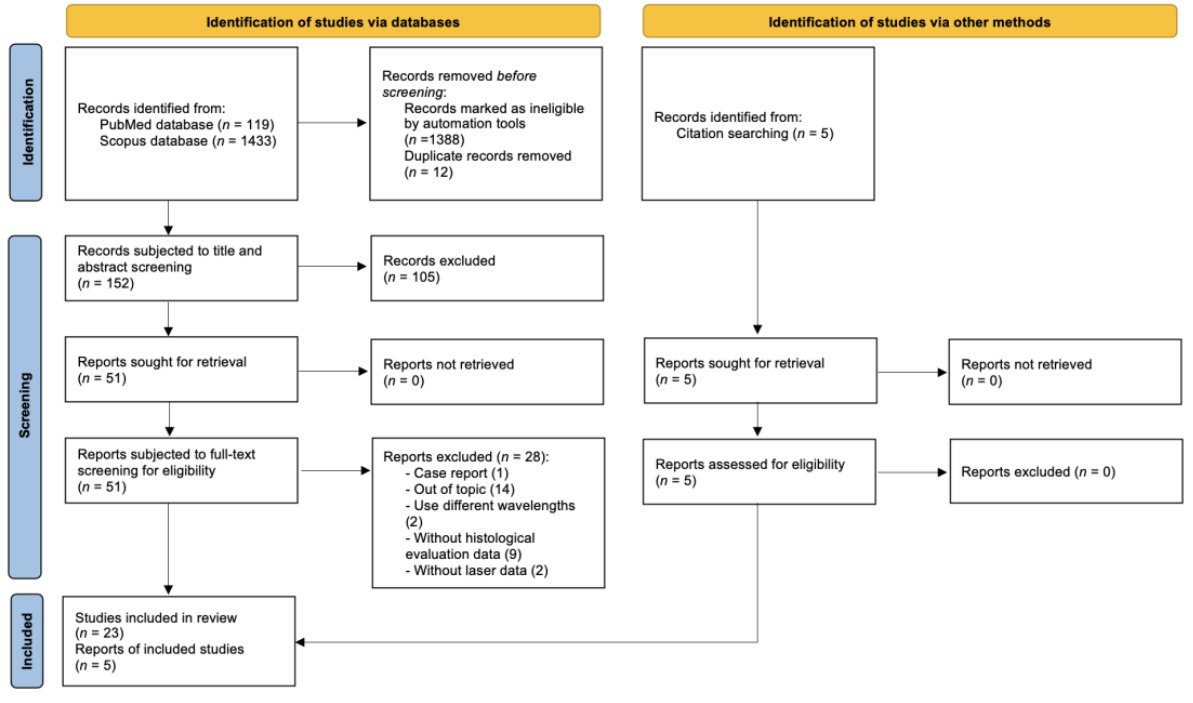
Figure 1. Flow diagram shows the study selection process.